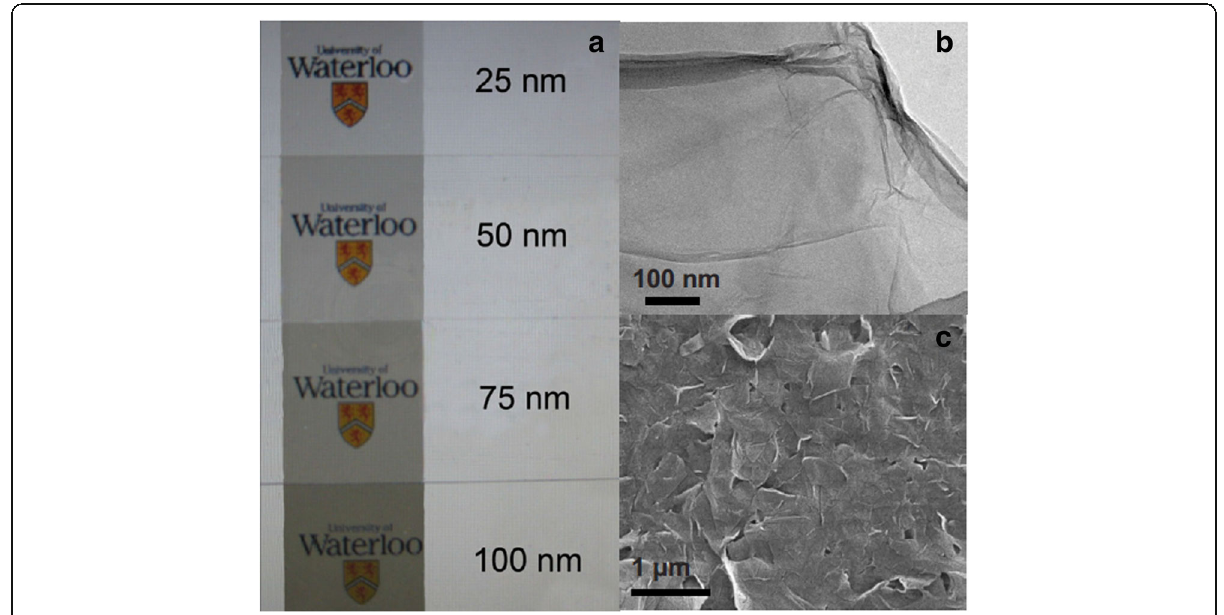
Fig. 11 a Photographs of transparent thin-films of varying thickness on glass slides. b TEM image of graphene collected from dispersion before filtration. c SEM image of 100 nm graphene film on glass slide. Reprinted with permission from [76]. Copyright 2012 AIP Publishing LLC